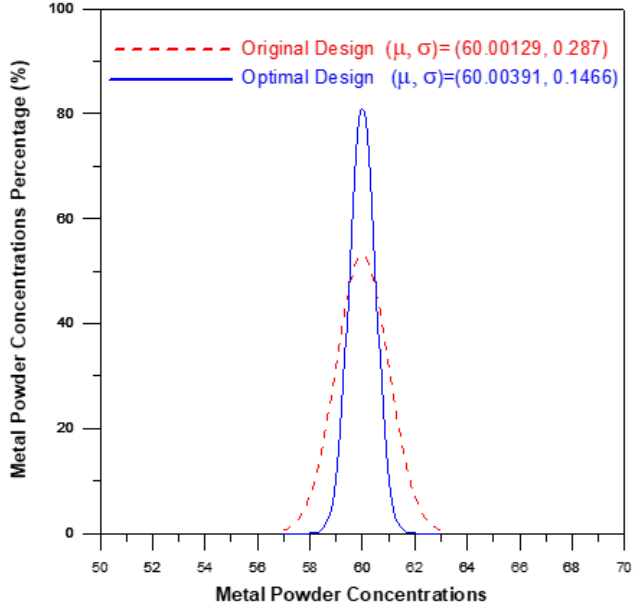
Figure 9. S/N response graph for Taguchi experiments.